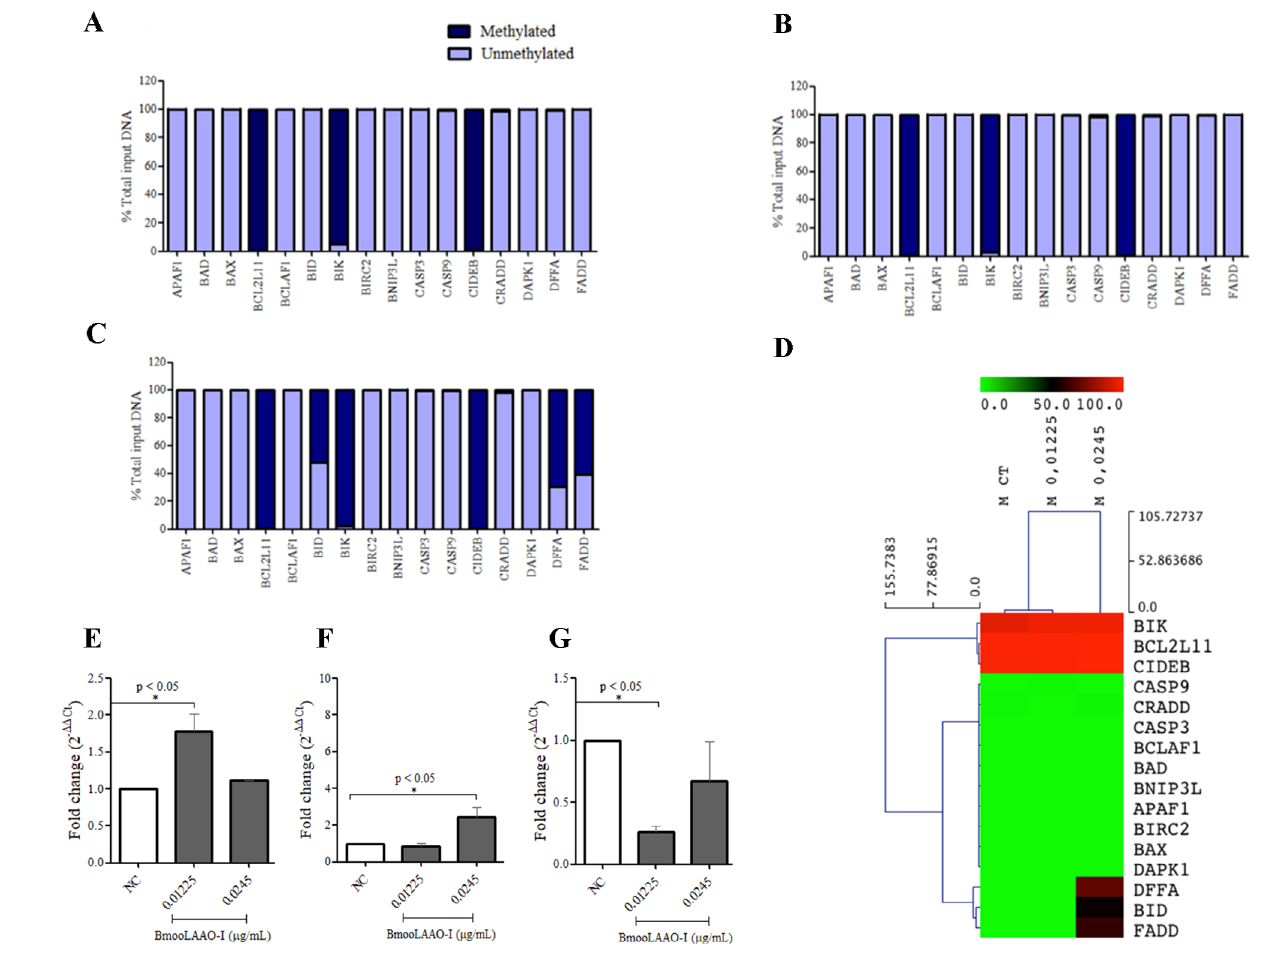
Figure 5. BmooLAAO-I modulates the apoptosis-related gene methylation pattern in K562-S cells. The percentage of methylation of the promoter region of apoptosis-related genes was quantified by real-time PCR in cells treated with BmooLAAO-I for 24 h. (A) Untreated cells (negative control). (B) Cells treated with the toxin at 0.01225 µg/mL. (C) Cells treated with the toxin at 0.0245 µg/mL. (D) Heatmap of sample clustering according to the percentage of methylated DNA. The horizontal bar in the top of the heatmap represents the color scale of percentage of methylation ranging from 0-100%. Expression levels of hypermethylated genes in K562-S cells treated with BmooLAAO-I. Expression of the genes (E) BID , (F) FADD , and (G) DFFA was quantified by real-time PCR after a 24 h treatment with BmooLAAO-I at sublethal concentrations (0.01225 and 0.0245 µg/mL). Results were expressed as mean fold change ± standard deviation of three independent experiments. NC: negative control (untreated cells). * p < 0.05 vs. NC (one-way ANOVA followed by the Tukey’s post-hoc